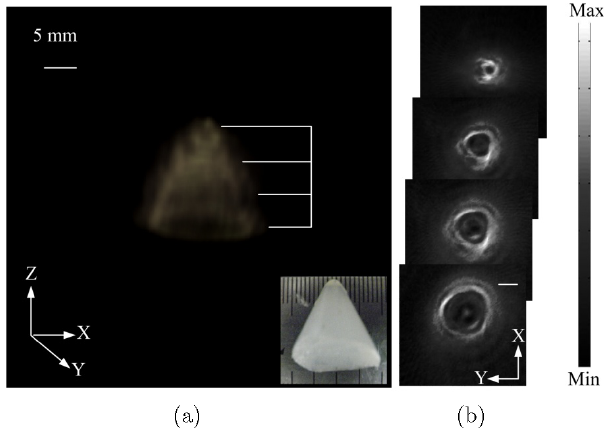
Fig. 4. (a) Three-dimensional thermoacoustic imaging of a mimicked tumor. (b) Four slices of two-dimensional thermo- acoustic images of the tumor correspond to Fig. 4(a).